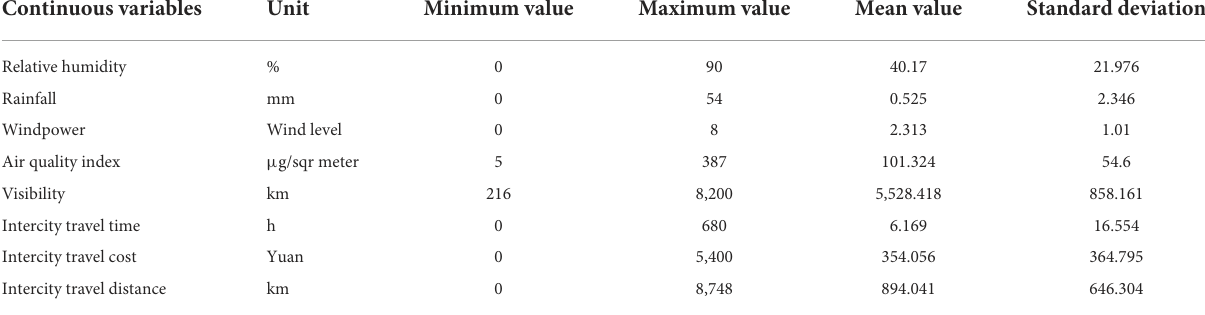
TABLE 5 Description of the continuous